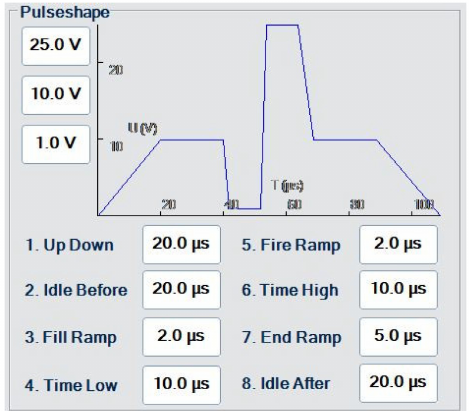
Figure 1. Default waveform of the PiXDRO LP50 inkjet printer from SUSS MicroTec [26], as used during